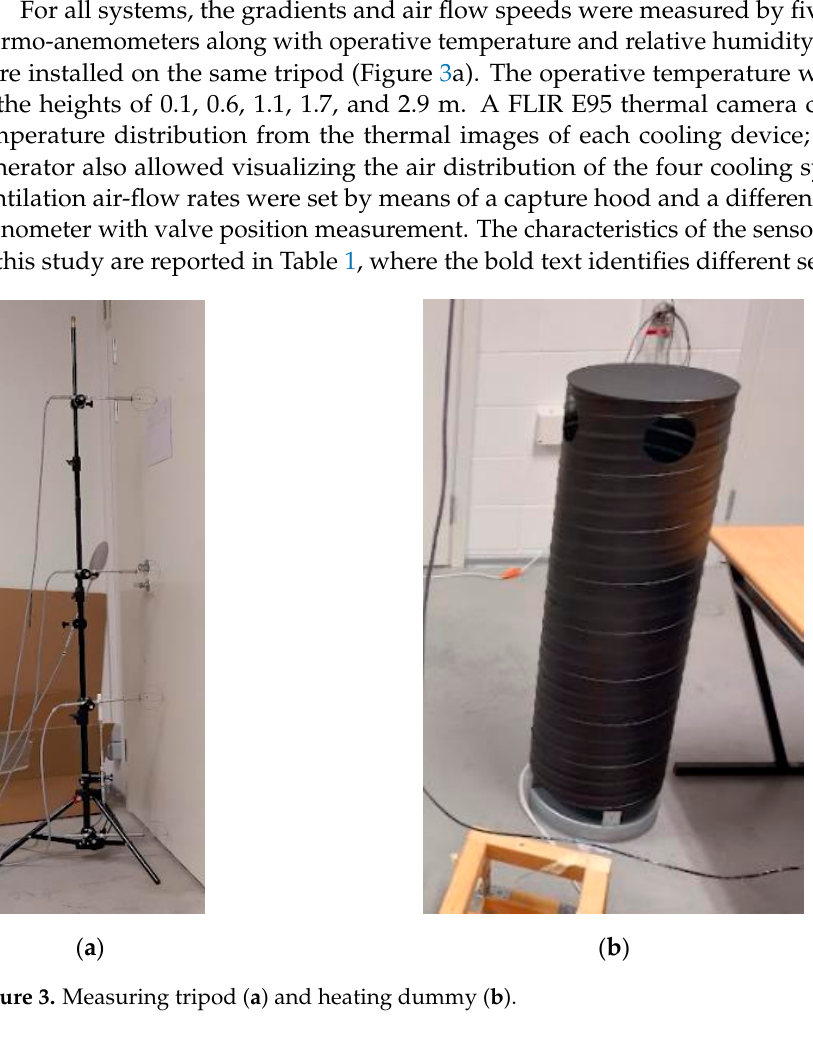
( b ) Figure 4. Tripod setup ( a ) for measuring the thermal comfort and ( b ) positioning of heating dum- mies (circles) and measuring tripod (cross).